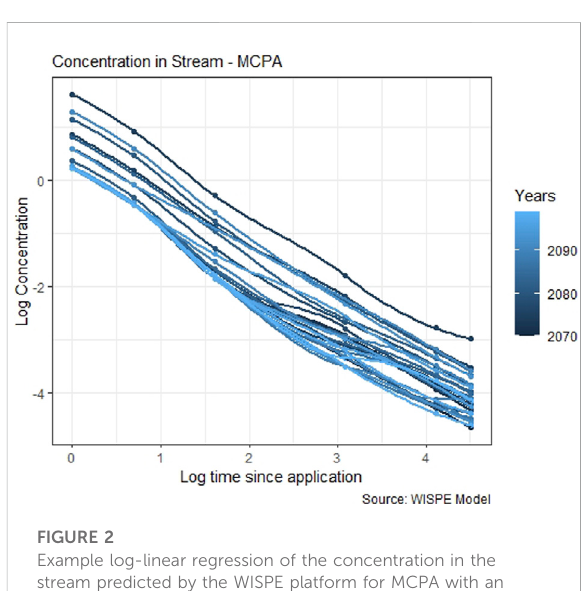
FIGURE 2 Example log-linear regression of the concentration in the stream predicted by the WISPE platform for MCPA with an application baseline scenario for the C1 and the time